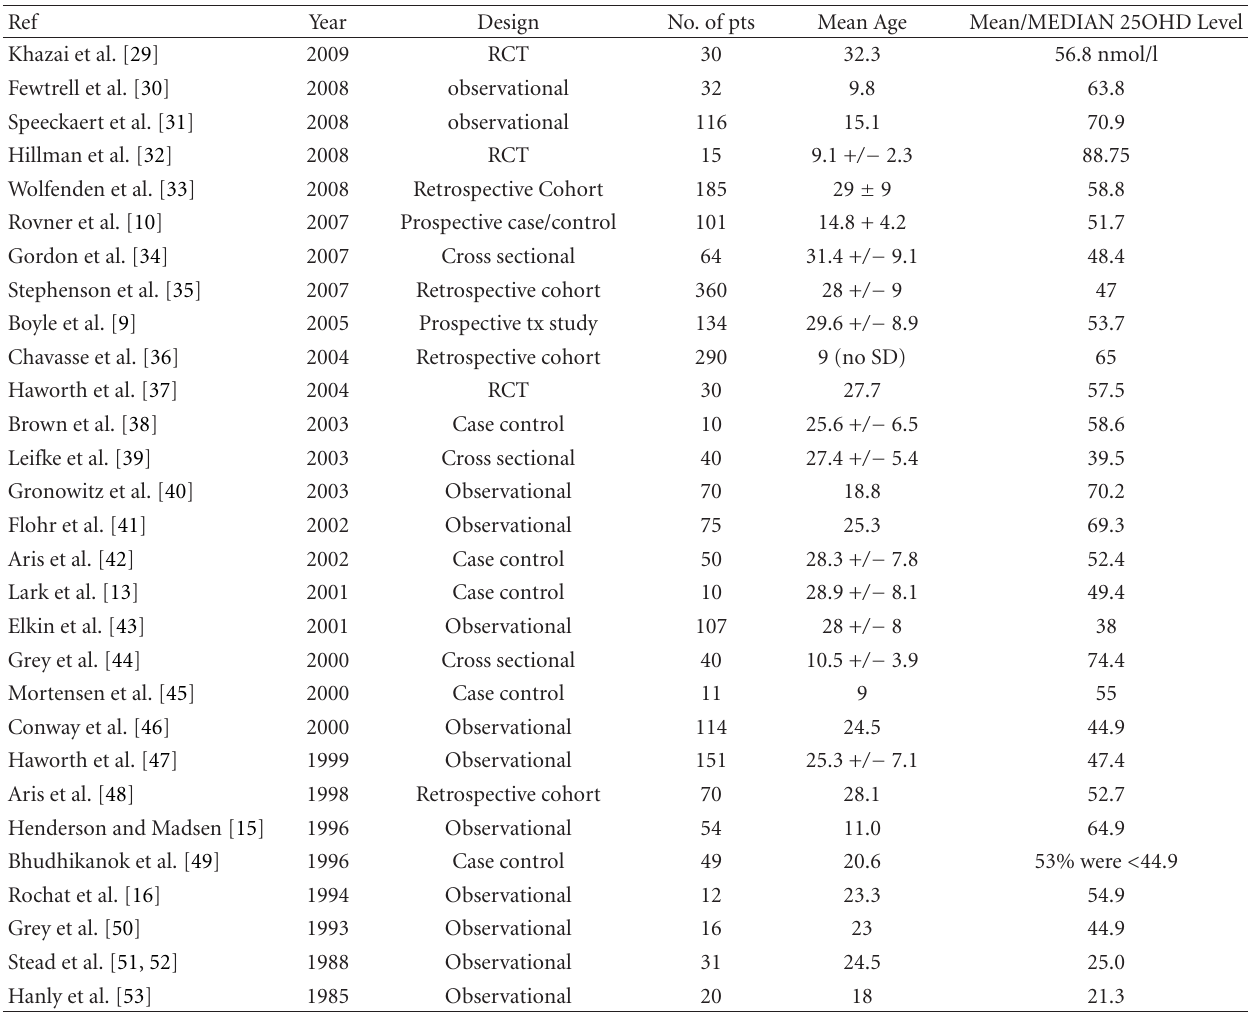
Table 1: 25OH vitamin D levels in CF